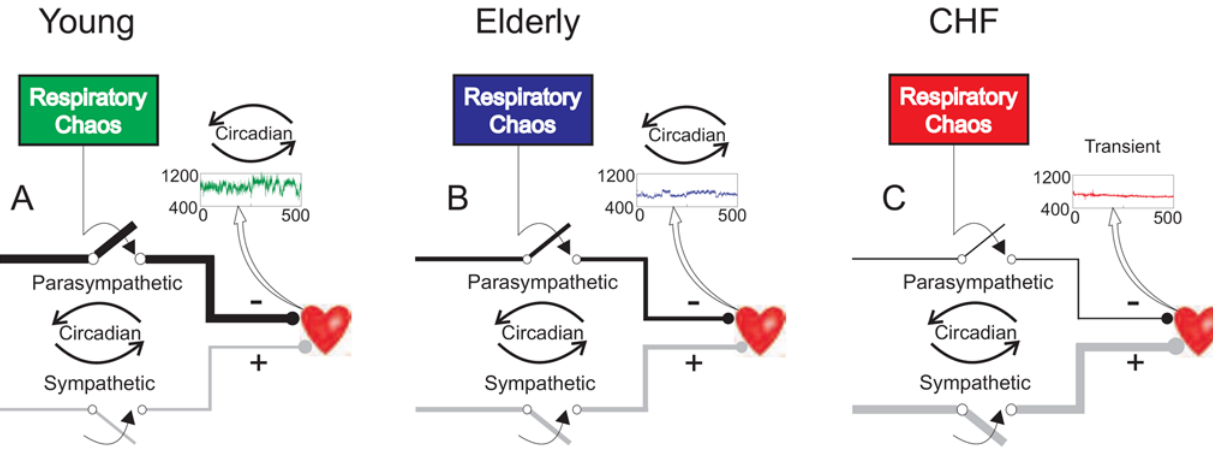
Figure 5. Mechanisms of high-frequency (HF) and transient heartbeat chaos in young, elderly and CHF subjects. Insets show representative 500-beat segments of RR interval series. A. In young subjects, chaotic respiratory rhythmic activity [29] introduces HF chaos in the heartbeat via preganglionic temporal gating (denoted by switches) of vagosympathetic outflows [35] and other mechanisms, resulting in respiratory sinus arrhythmia. Respiration confers the chaotic dynamics of the HF component whereas vagal-cardiac tone (indicated by line thickness) sets the chaos level (HF power) relative to noise floor (LF power). Hence LF/HF is reciprocal to the S/N of HF chaos. Parasympathetic outflow slows ( 2 ) the heart rate but increases HF power, whereas sympathetic outflow does the opposite ( + ). Nocturnal increases of parasympathetic outflow and decreases of sympathetic outflow result in corresponding circadian (curved arrows) variations of the S/N of HF chaos and hence, DR and NL. B. Elderly subjects exhibit proportionate decreases in parasympathetic-mediated HF and LF power, with almost invariant LF/HF compared with young subjects (Figs. 1K, 2E). DR and NL are similar to those of young subjects because the effective S/N are largely unchanged even though the intensity of HF chaos (in terms of the HF power) decreases with age. C. In CHF patients, parasympathetic-mediated circadian HF and LF power are greatly suppressed and transient heartbeat chaos intrinsic to cardiac dynamics emerges.